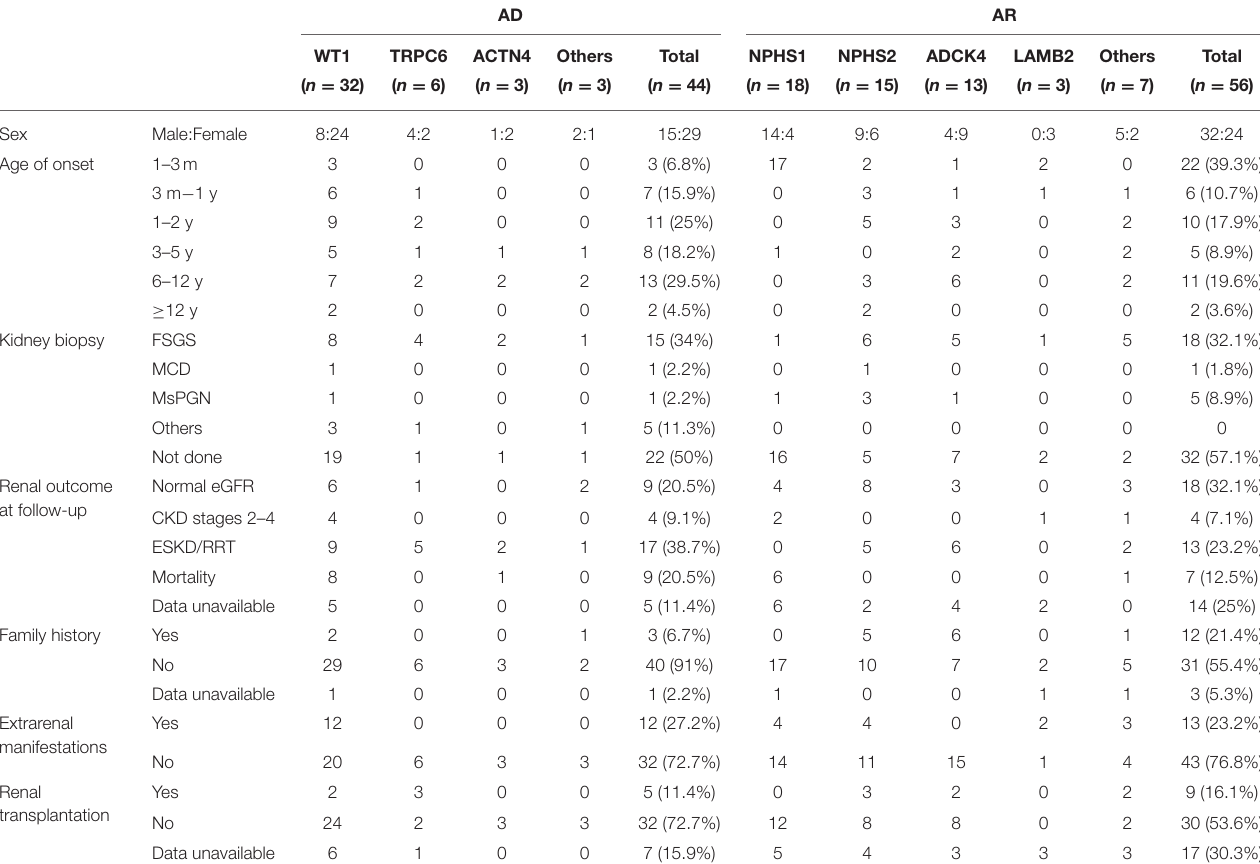
TABLE 3 | Genotype-phenotype correlations in pediatric patients with steroid-resistant nephrotic syndrome of AD mutation and AR